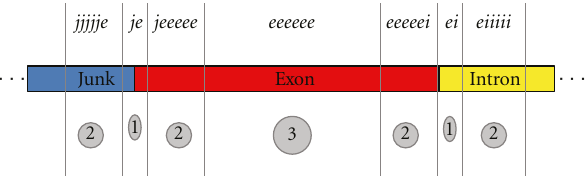
Figure 1: Three kinds of emission mechanisms: (1) position- dependent emission, (2) hash-interpolated emission, and (3) normal emission. Based on the relative distance from the state tran- sition point, we first encounter the position-dependent emissions (denoted as (1)), then we use the zone-dependent emissions (2), and finally, we encounter the normal state emissions (denoted as